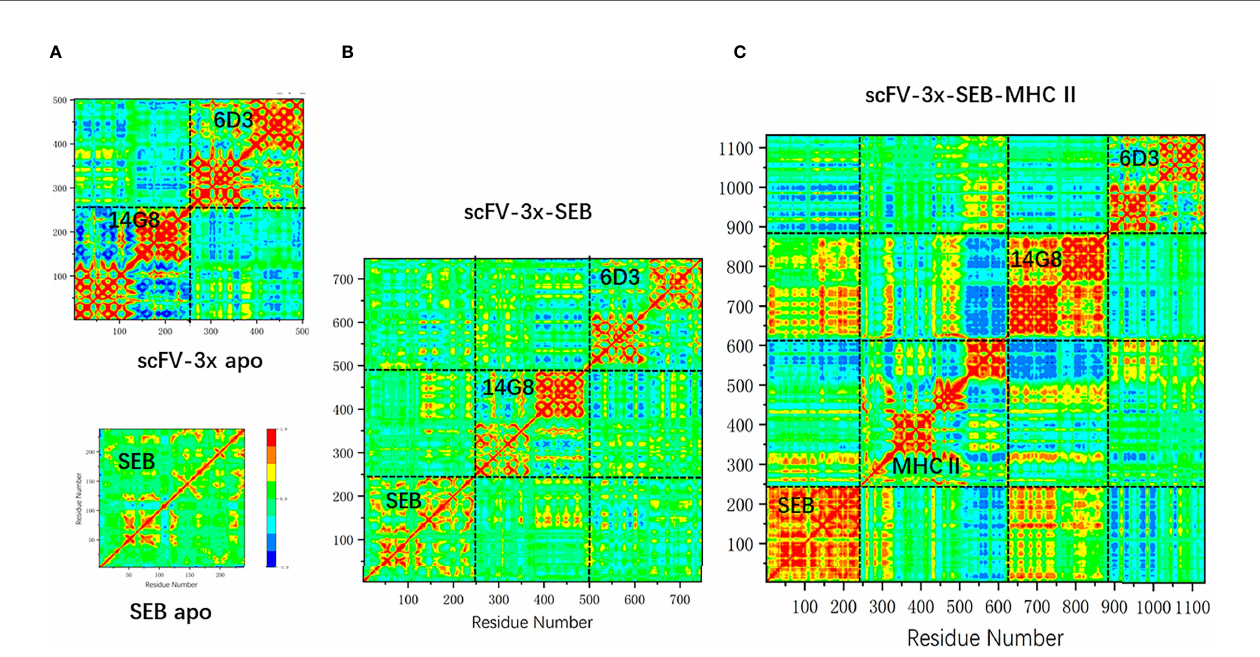
FIGURE 7 | The change of covariance matrix of SEB and scFV-3x in different binding states. Red (blue) color corresponds to positive (negative) correlation in which residues move in the same (opposite) direction. (A) Isolated MB102a (scFV-3x, upper panel) and SEB (lower panel). (B) scFV-3x-SEB complex. (C) scFV-3x-SEB- MHC II complex.